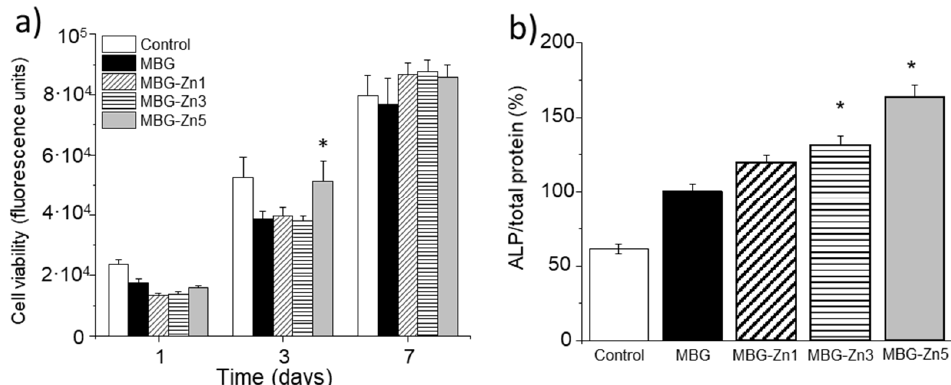
Figure 6. MC3T3-E1 preosteoblast viability at 1, 3, and 7 days ( a ) and ALP activity after 7 days of culture ( b ) in the presence of MBG and ZnO-containing MBGs. * p < 0.05.